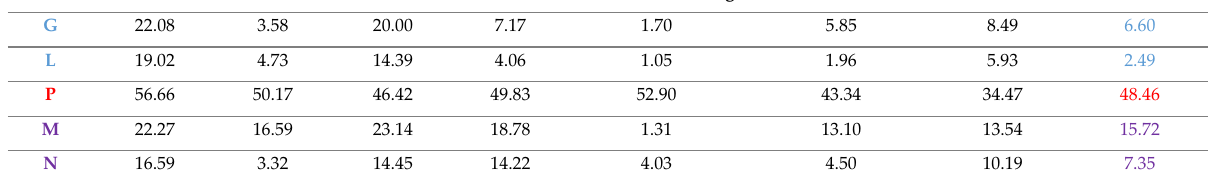
Table 1. Intrinsic disorder in structural proteins of CHPV. Protein names and their mean PPIDs are colored (highly disordered- red, moderately disordered- purple, and ordered- light blue) to show their disorder